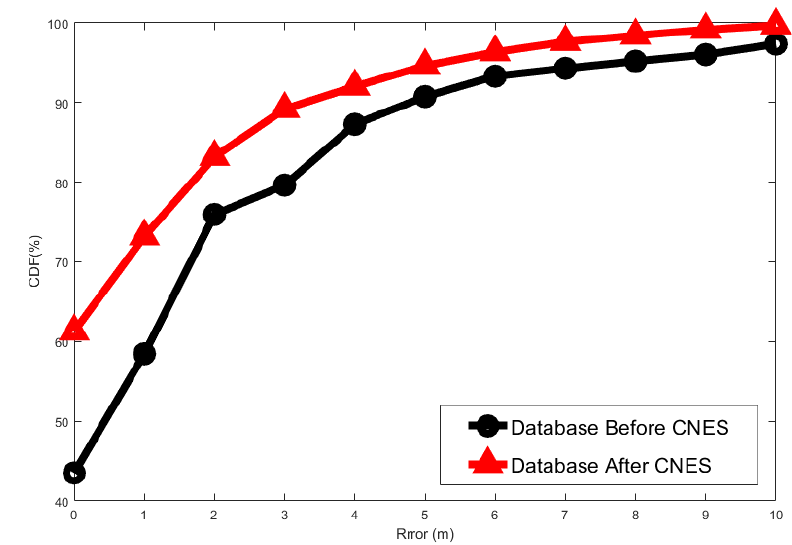
Figure 13. Cumulative distribution function (cdf) vs. distance error. X -axis represents positioning errors and Y -axis represents the positioning accuracy for different positioning errors.